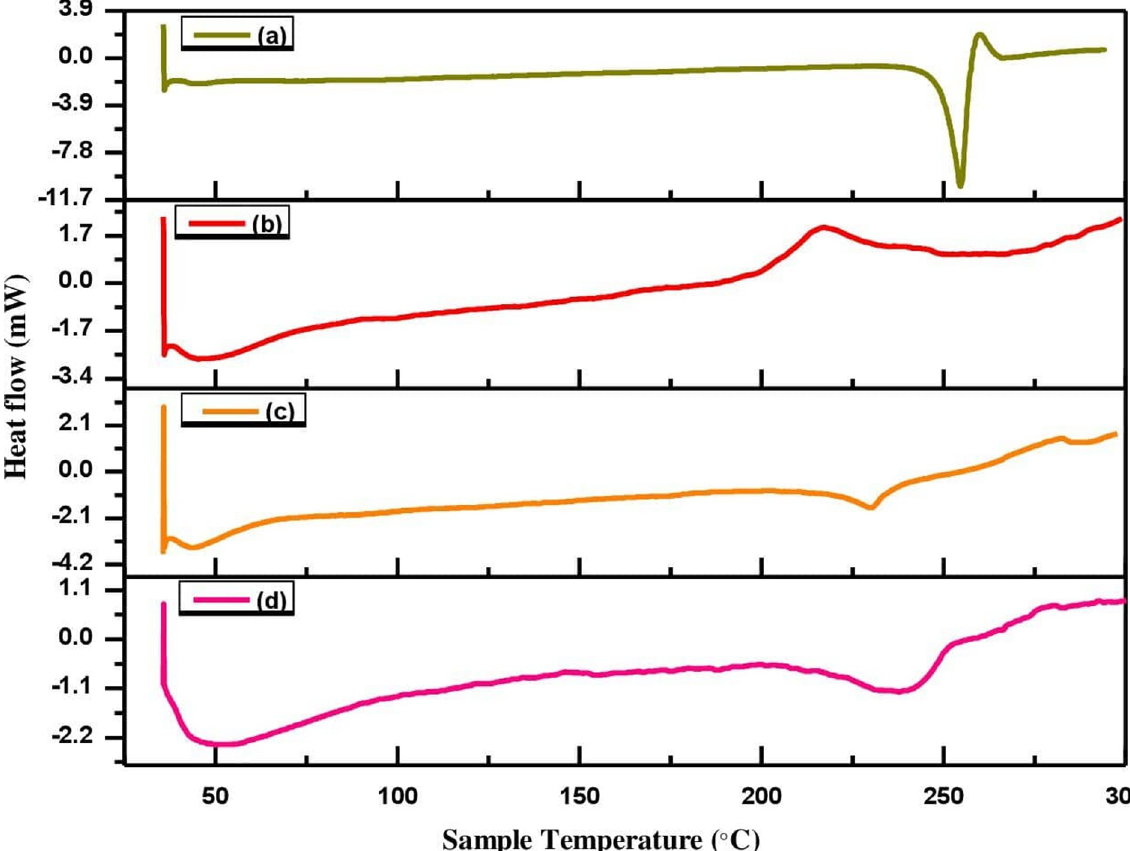
Fig 8. DSC of MLX (a), HPMC (b), physical mixture of MLX as well as HPMC (c), and optimized formulation (F0), (d).